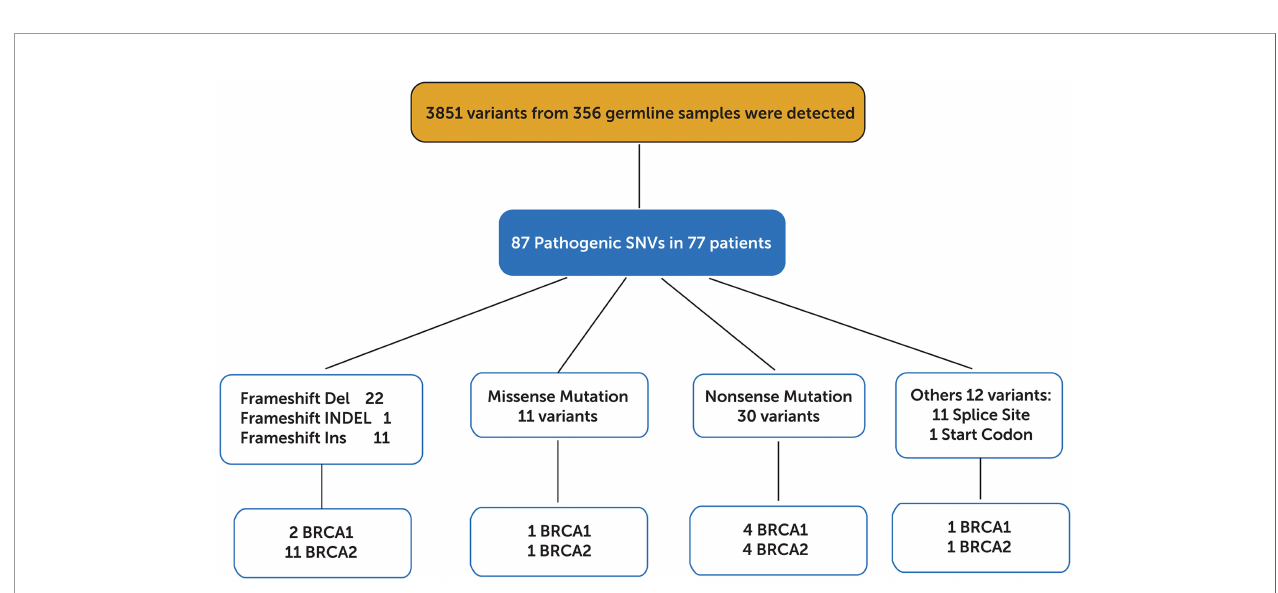
FIGURE 2 | Distribution of 3851 variants detected in 356 germline